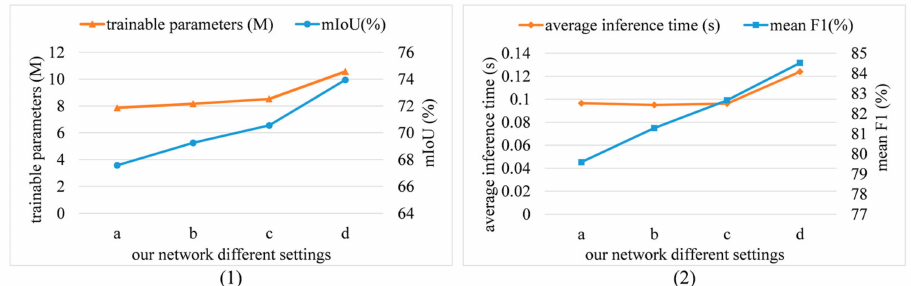
Figure 12. Our network di ff erent settings’ speed and accuracy analysis for the Shanghai dataset. (1) Changes of trainable parameters and mIoU with di ff erent settings; (2) changes of the average inference time and mean F 1 with di ff erent settings; a: Basic network; b: basic network + SREB; c: basic network + SREB + CREB; d: basic network + SREB + CREB +